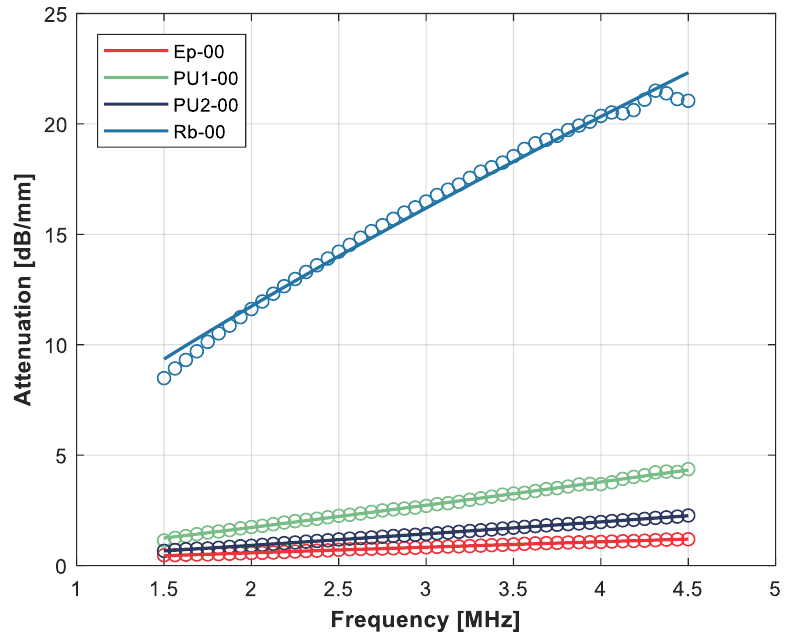
Figure 1. Variation in the ultrasonic attenuation coefficient with the frequency for the raw materials. Open circles: measurements. Solid line: fitting using a power law.